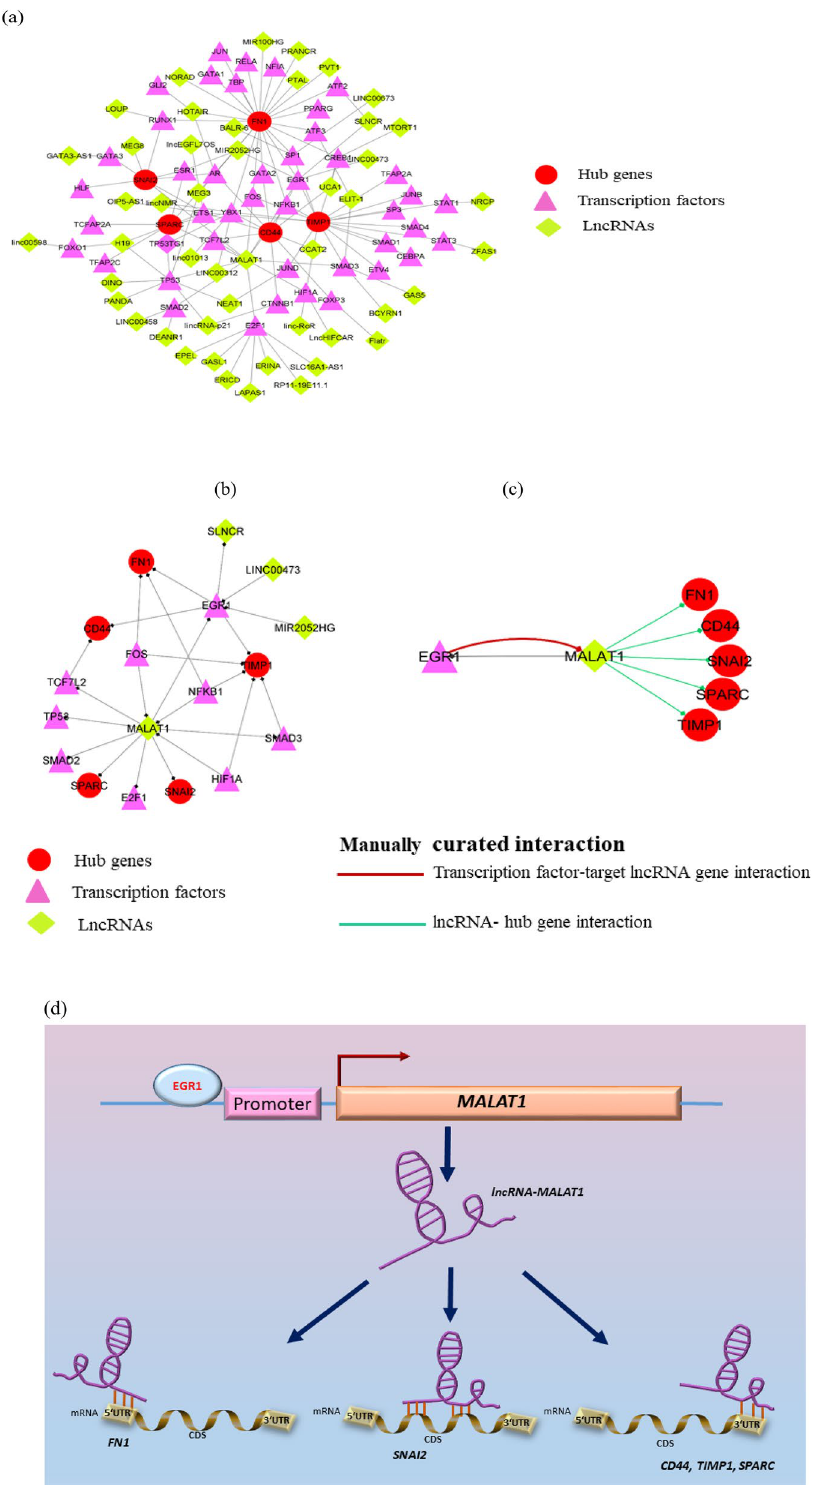
Figure 4. Regulatory network of LncRNAs-TFs-Driver genes and working model ( a ) Master regulatory network of LncRNA- TF-Driver genes. Regulatory interactions between lncRNAs, TFs and driver genes are depicted in this integrated network, b-c:EGR1 and MALAT1 s ubnetwork from the master regulatory network. ( b ) Transcription Factor EGR1 is observed to be regulating three hub genes ( FN1, CD44 and TIMP1) and also being regulated by MALAT1 ( c ) EGR1- MALAT1 interaction (red-colored edge) and MALAT1 -mRNA interaction (hub genes, green-colored edges) obtained from the ENCODE transcription factor targets dataset of the Harmonizome database and lncRNA-mRNA interaction database, respectively, ( d ): A working model for the regulation of key driver genes associated with pan-cancer multi-drug resistance: Transcription factor EGR1 may regulate MALAT1 transcription . After being transcribed, MALAT1 is predicted to bind to different sites, 5 ′ -UTR, CDS, and 3 ′ -UTR, of specific mRNAs, thereby regulating these key driver genes through cis- or trans- acting